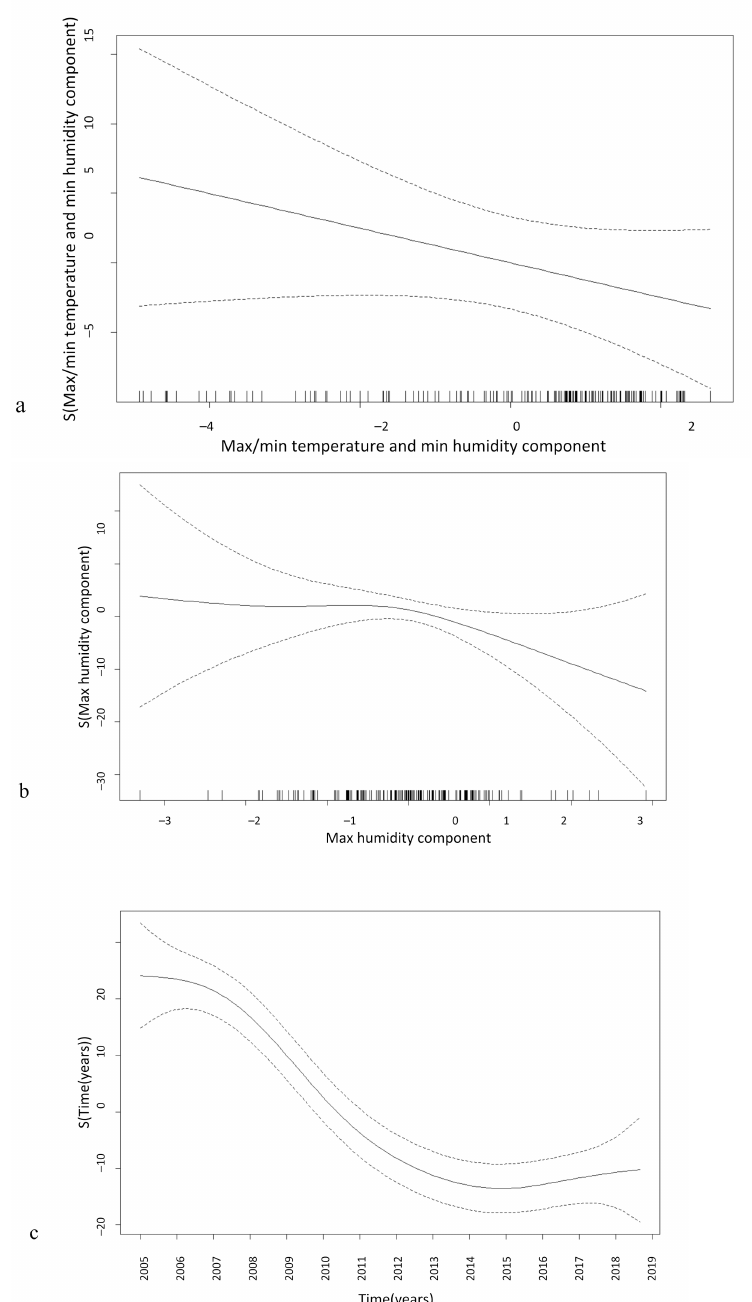
Figure 5. Generalized additive model for relationship between total malaria incidence ( P. falciparum and P. vivax ) and the first meteorological component ( a —maximum and minimum temperature and maximum humidity), the second component ( b —maximum humidity), and time ( c ). The solid black line indicates the smooth relationship with 95% confidence intervals (dashed